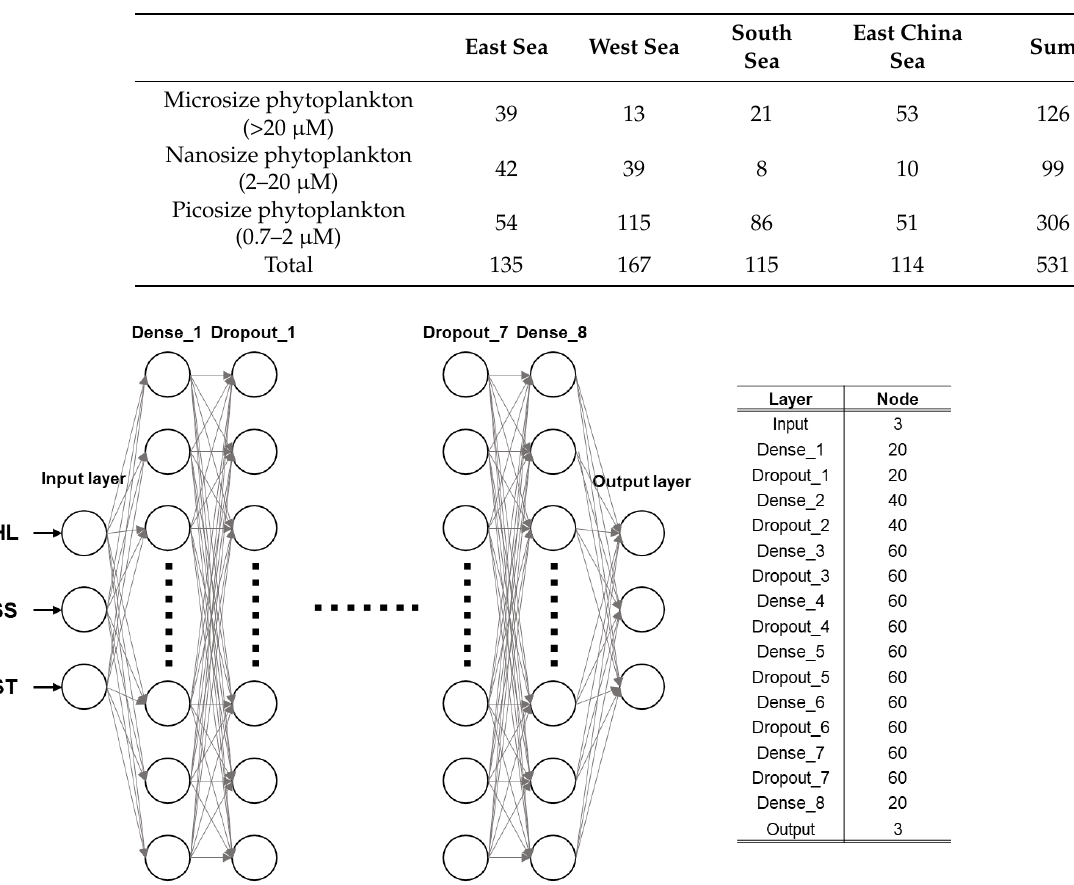
Figure 2. Deep learning framework of this study model. As training data, the total chlorophyll-a (CHL), total suspended solids (TSS), and sea surface temperature (SST), obtained by field observation, were used as input variables in this model.